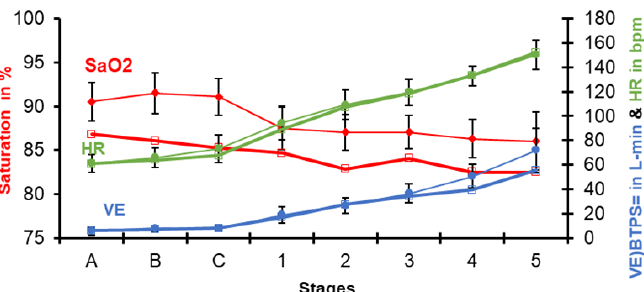
Figure 3. Same procedure as in Figure 2, this time comparing the previous mean values of 15 healthy subjects with those of a patient with Poly-ErythroCythemia (PEH) (in thick lines) at 3500 m. These studies are valuable for the diagnosis of cardio-pulmonary disease at high al- titude. They help understand how CMS, or rather poly-erythrocythemia (PEH), is errone- ously considered a single illness, actually it being multiple diseases that try to compensate cardio or respiratory inefficiencies (organ dysfunction) by increasing the red blood cells [16]. However, regardless of the elevated hematocrit, exercise is carried out and achieved as well as normal residents at 3500 m. This was observed by several authors [23,24]. It is important to note that the first component of the Oxygen Transport Triad “moves” oxygen from the environment to the lungs with the vacuum produced in the pneumo-dynamic pump [25]. Oxygen is then transferred through the alveolar-capillary membrane by “diffusion and only by diffusion”, quoting the great August Krogh [26]. Oxygen is subsequently captured by hemoglobin. After that, the hemo-dynamic pump moves the hemoglobin oxygen-filled blood through a compression mechanism (the heart) to the tissue capillaries. The diffusion process then repeats itself at the cellular level to reach the mitochondria. At any altitude, biology follows the laws of physics within the Oxygen Transport Triad (Figure 4). As air enters the upper airway tract from an environ- mental PIO 2 , it increases volume from Ambient Temperature Pressure Standard (ATPS)